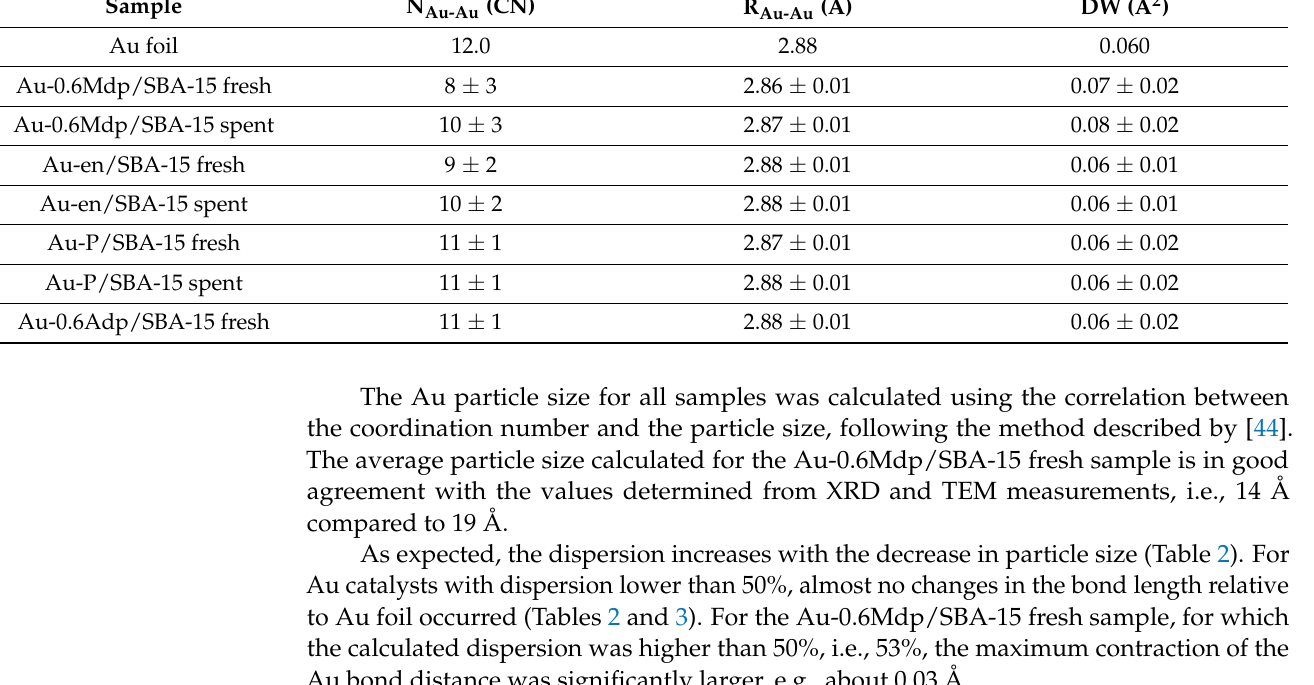
Table 3. Structural parameters as revealed from EXAFS data